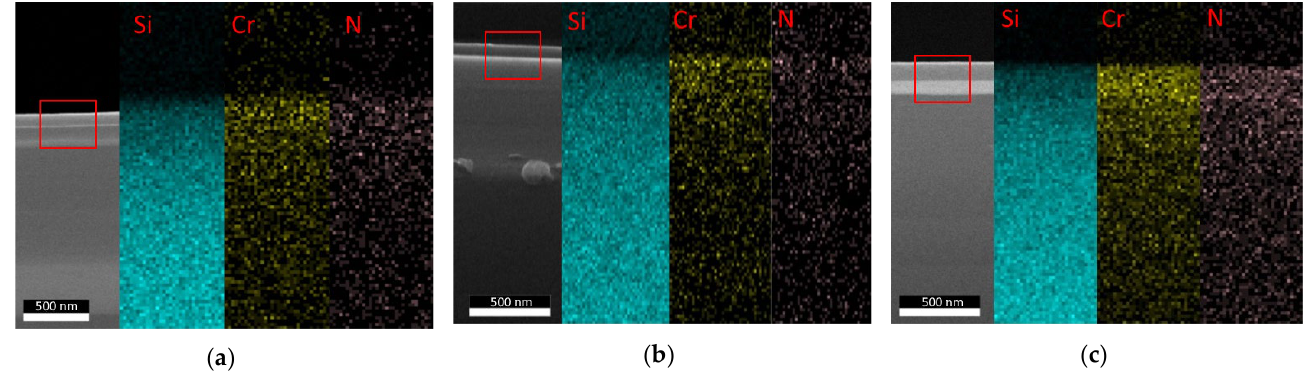
Figure 3. EDAX elemental mapping showing the distribution of chemical elements using the HiPIMS power supply for the deposition times of ( a ) 5 min, ( b ) 10 min, and ( c ) 15 min. The distribution of Cr and N in the deposited layer (Figures 2 and 3) is homogeneous and uniform with no noticeable defects in the deposition layer. It is therefore expected that the thin CrN layer will provide corrosion resistance for the Si surface beneath. The interaction (diffusion) at the deposition/substrate interface can also be